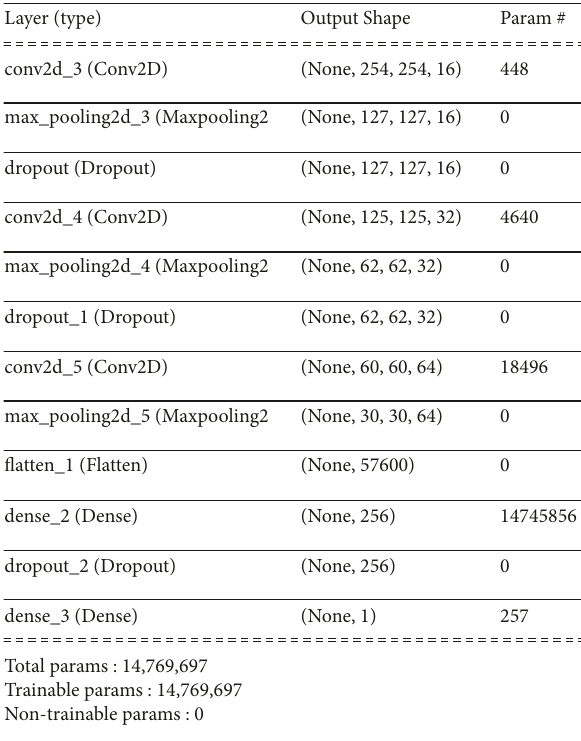
Figure 4: CNN model three architecture from summary ( ) function.